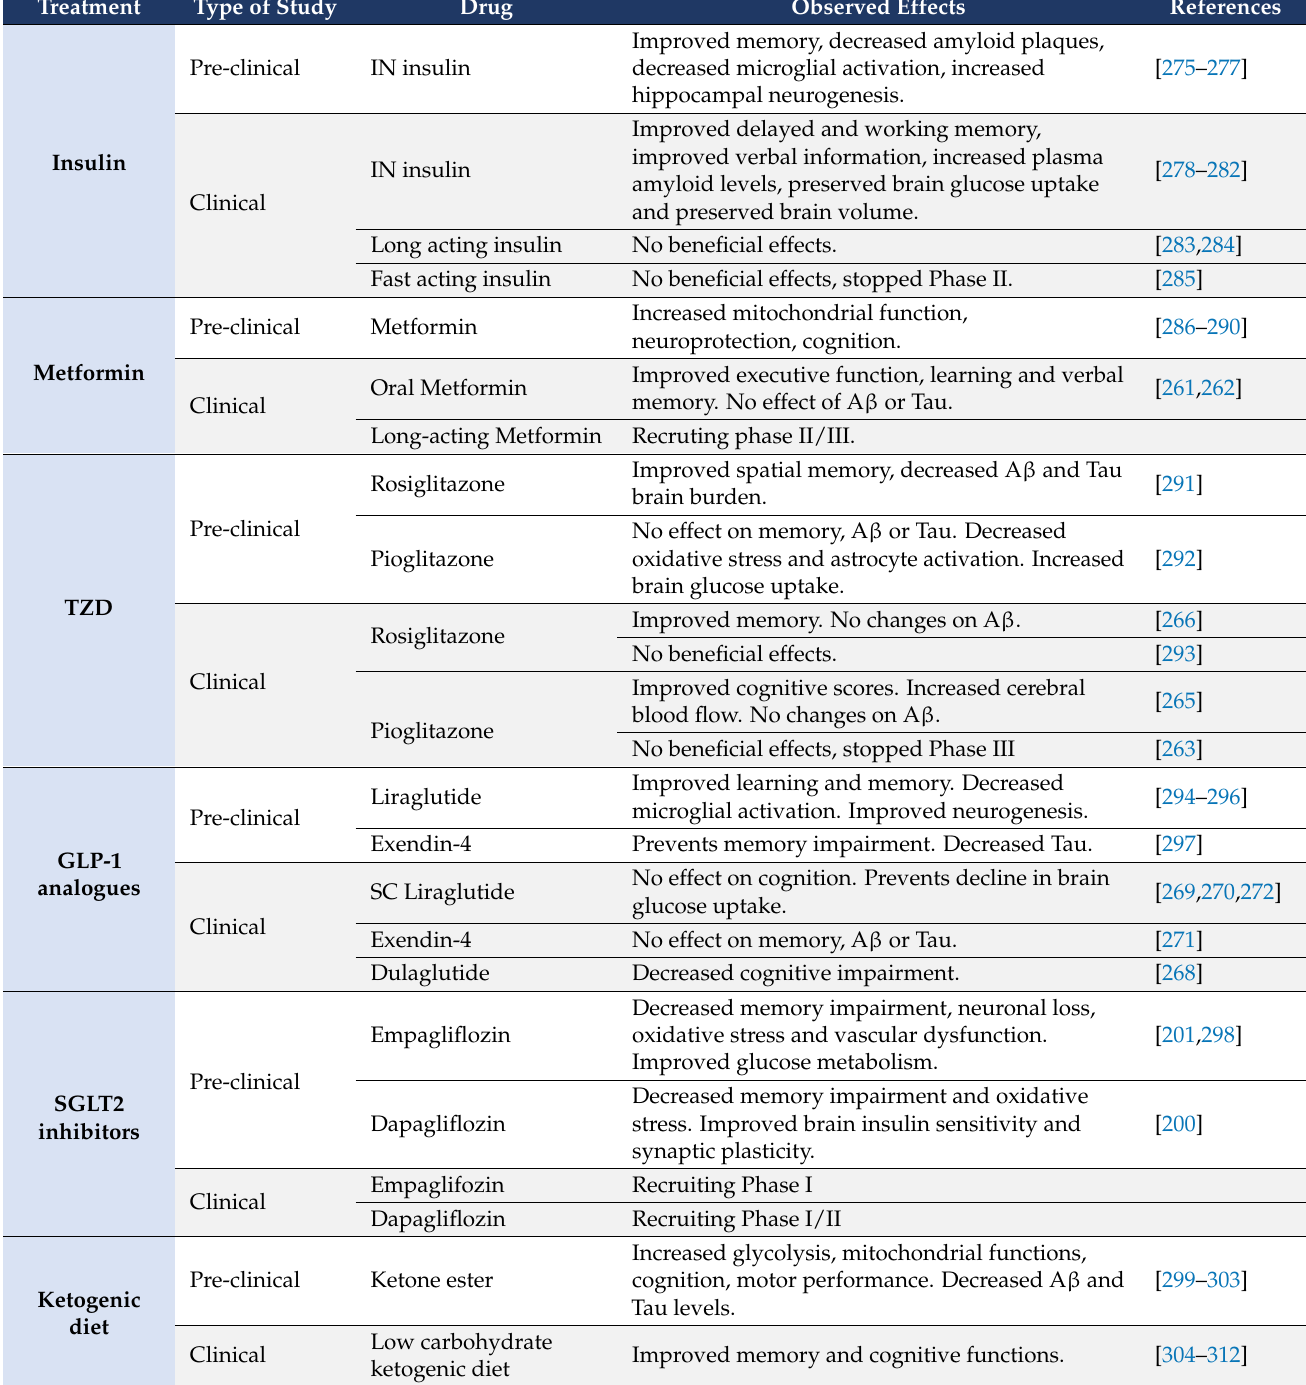
Table 3. Clinical and pre-clinical metabolic-related intervention for the treatment of